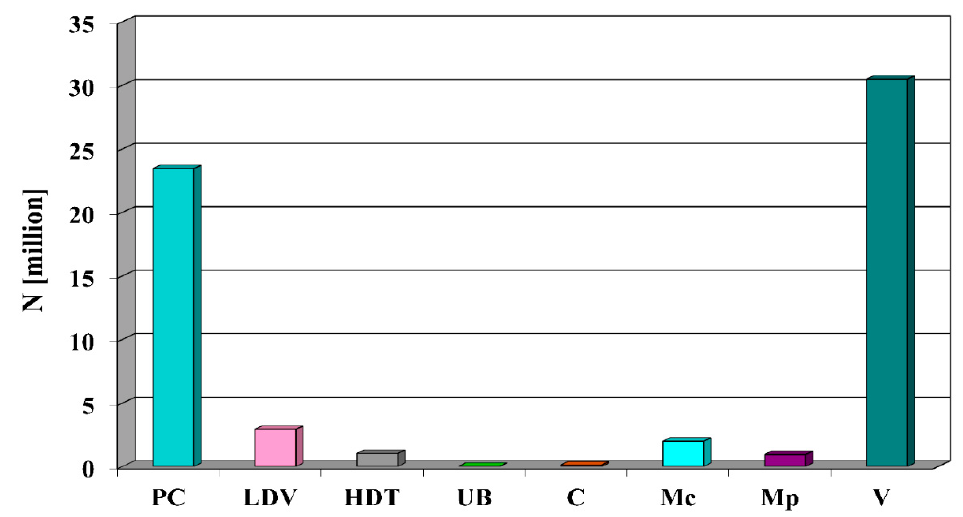
Figure 2. Number (N) of passenger cars (PC), light duty vehicles (LDV), heavy duty vehicles (HDT), urban buses (UB), coaches (C), motorcycles and quads (Mc), mopeds (Mp) and all vehicles (V).